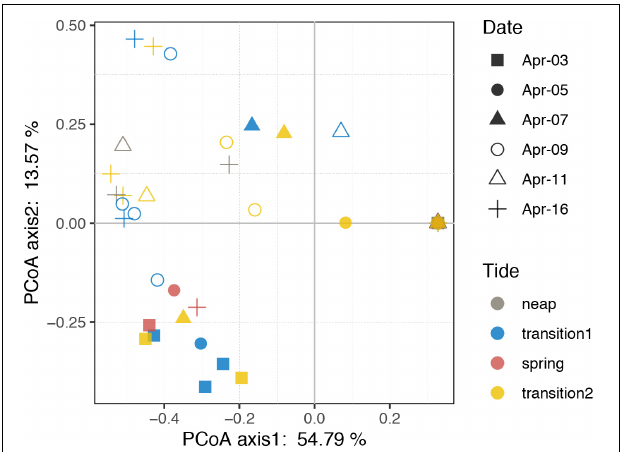
FIGURE 4 | Principal coordinate analysis plot based on Bray–Curtis dissimilarity of the ciliate community. Neap, transition, and spring tide were distinguished based on the distinct variations of tidal range. Transition 1 and 2 represents the transition from neap to spring and from spring to neap tides,